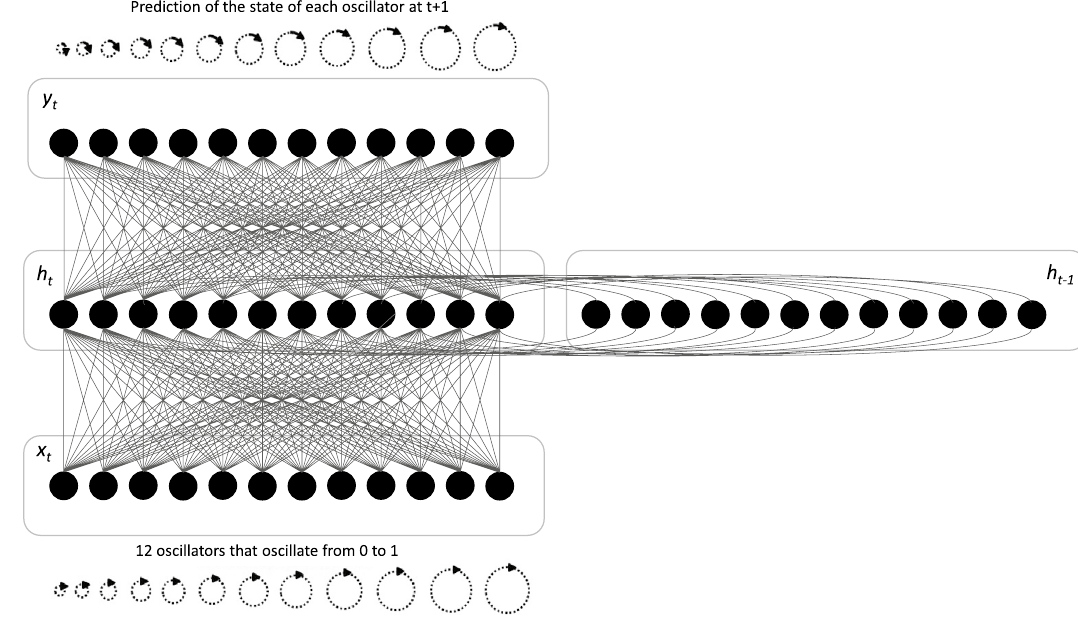
Figure 1. Representation of the Simple Recurrent Neural Network model, with x t , input vector of the 12 oscillators at t0, ht , hidden layer vector at time t ; x t +1 output vector; A , R , U parameters paired with each layer. The Figure was designed by the present authors.